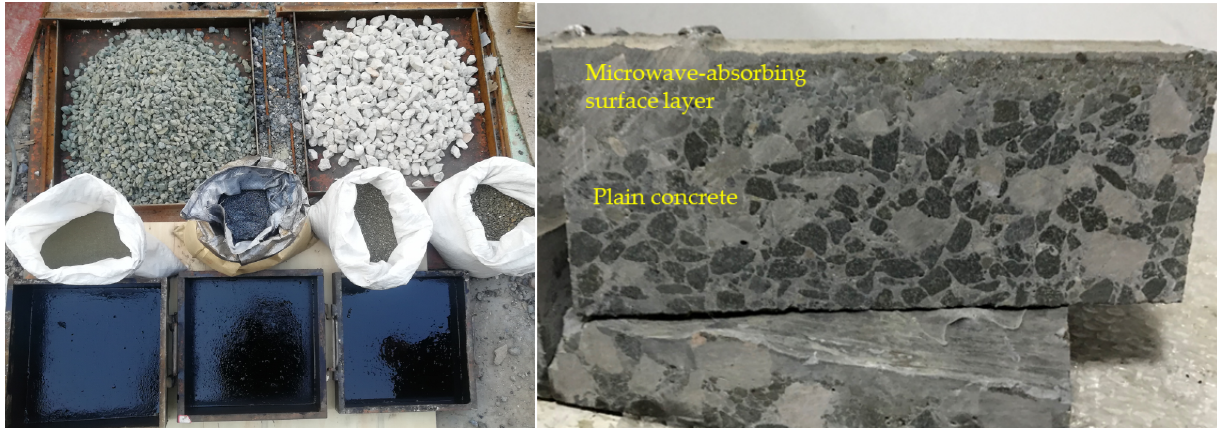
Figure 2. Raw materials of the scattered microwave-absorbing surface and the microwave-absorbing concrete specimens.